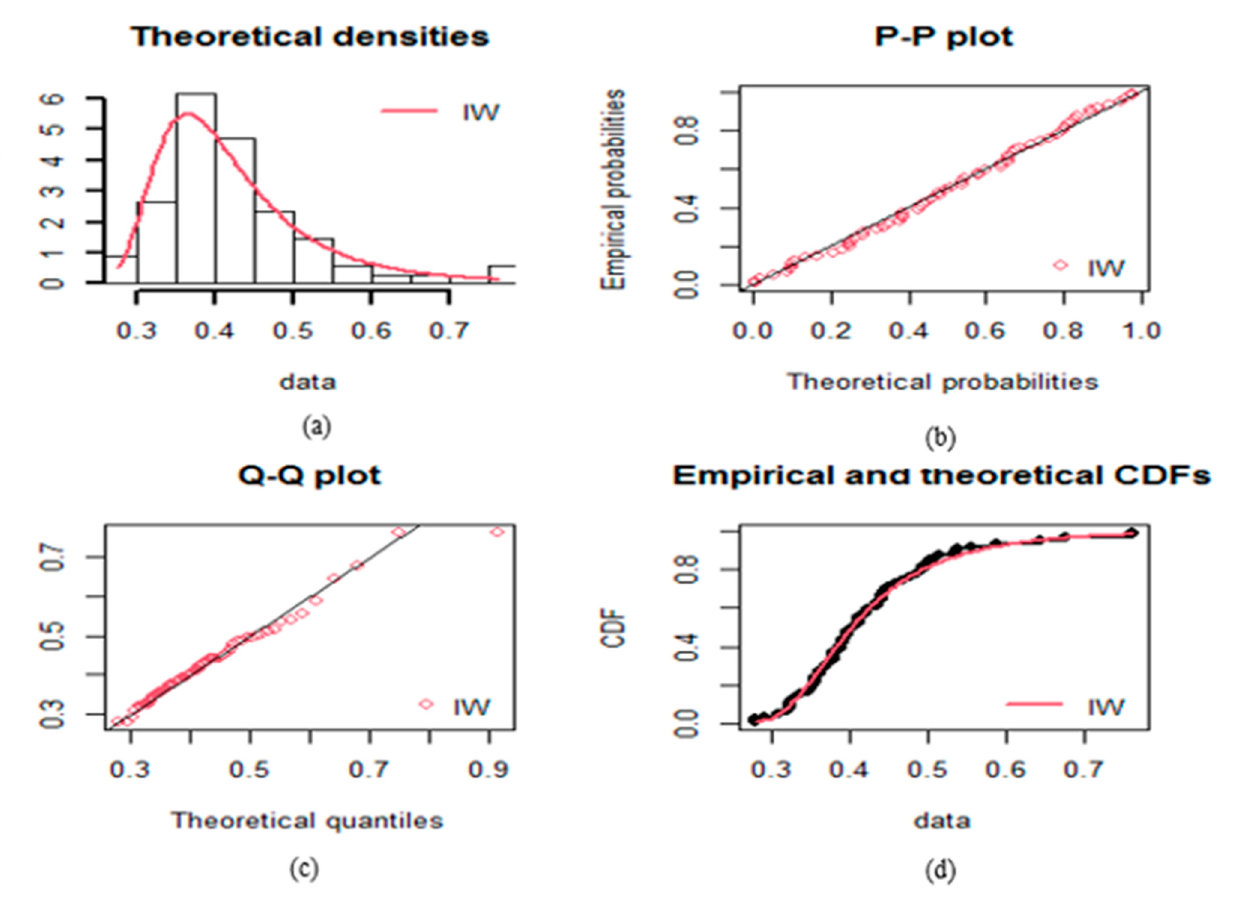
Figure 1. Examples of fits of IWD for the Strength ( X ) dataset: ( a ) histogram fitted by the estimated pdf, ( b ) empirical cdf fitted by the estimated cdf, ( c ) P-P plot, and ( d ) Q-Q plot.